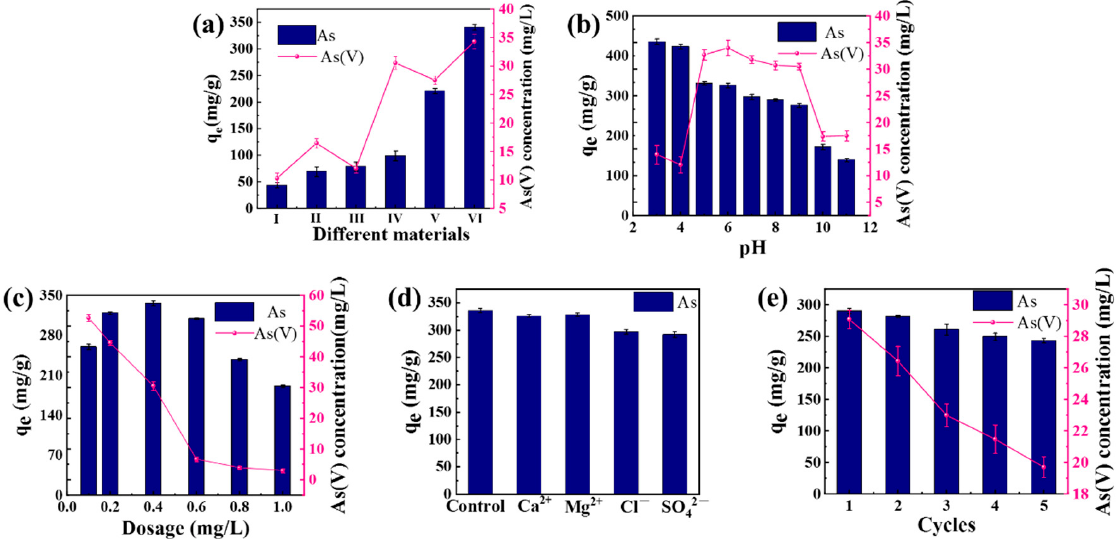
Figure 4. Effect of the ( a ) different materials, (I–VI representing CNTs, functionalized CNTs, MXene, nZVI/MXene, MXene/CNTs and nZVI/MXene@CNTs, respectively); ( b ) initial pH; ( c ) dosage of nZVI/MXene@CNTs; ( d ) coexisting ionic on the As(III) removal from aqueous solution by nZVI/MXene@CNTs; and ( e ) reusability of nZVI/MXene@CNTs.